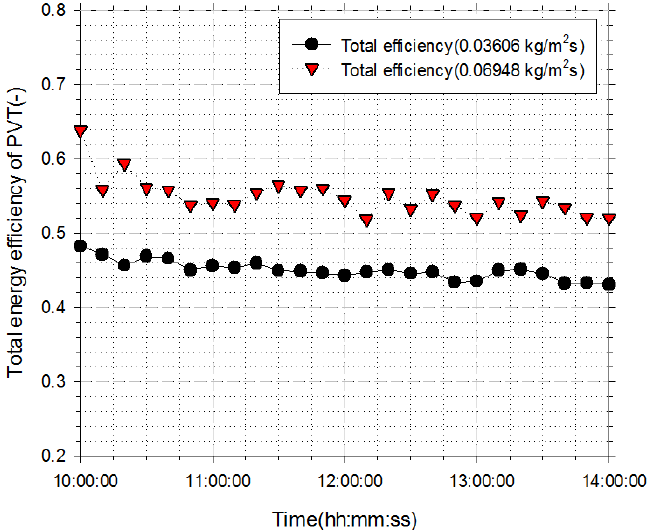
Figure 10. The total energy efficiency of the PVT air collector with operating time.